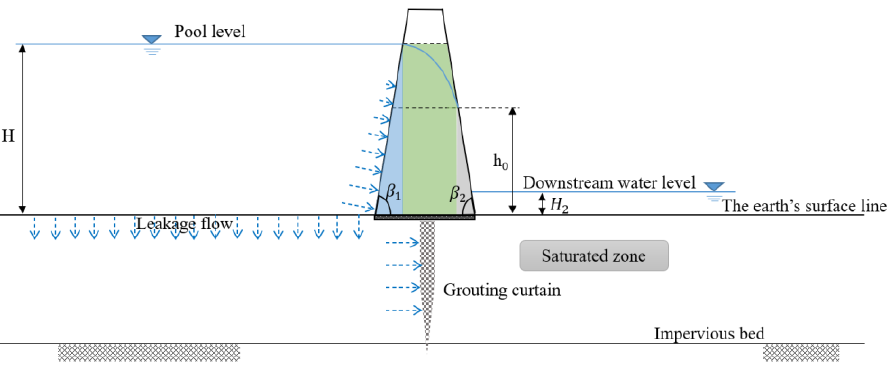
Figure 12. The cross-section of the core.